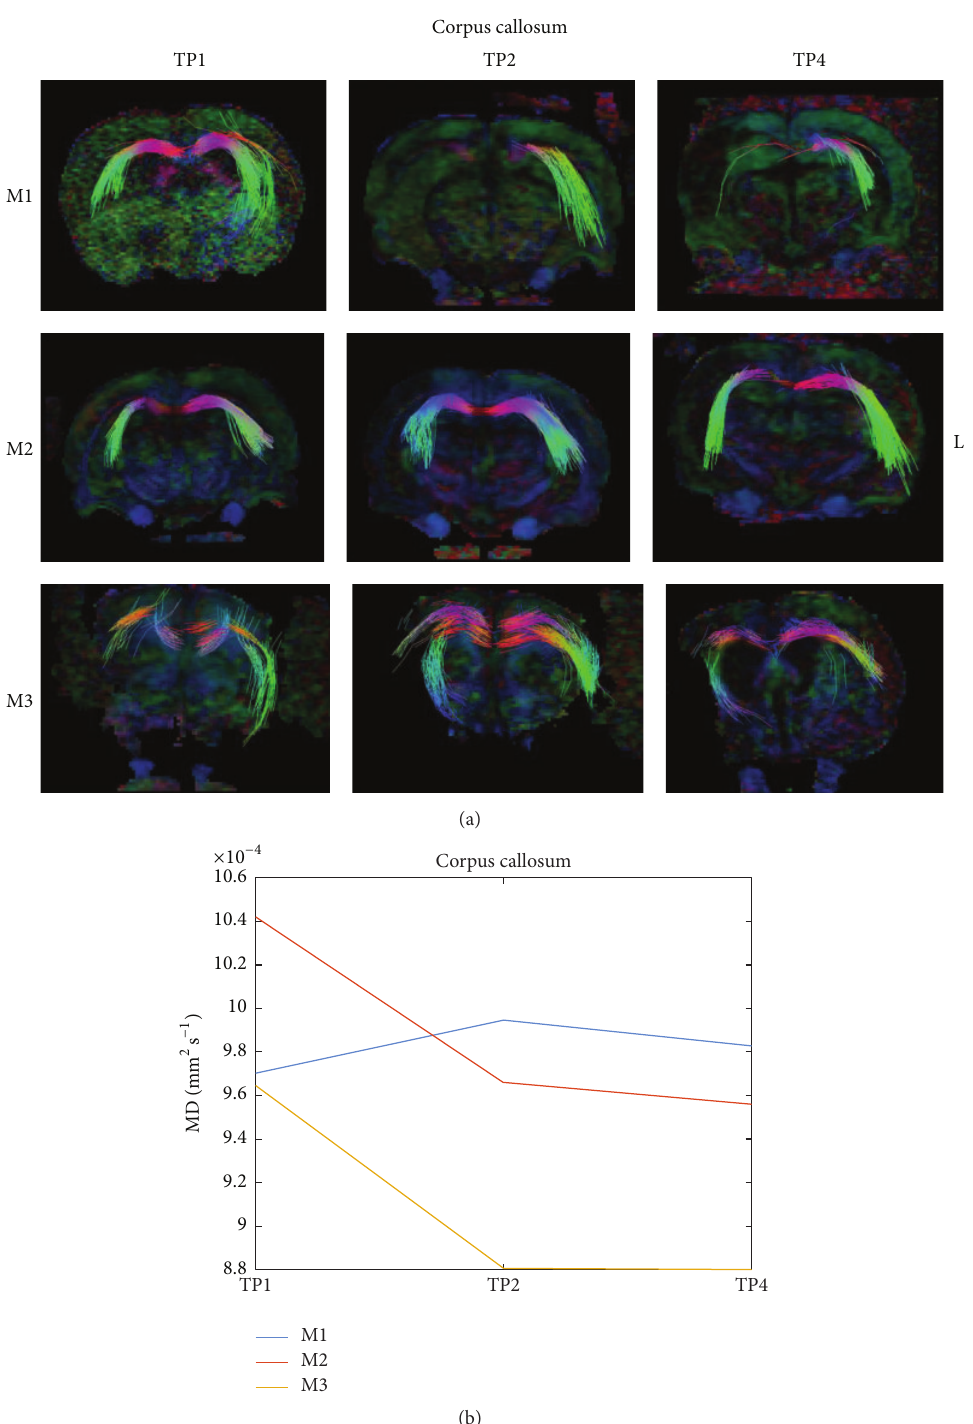
Figure 6: DTI of corpus callosum. A reconstruction of the corpus callosum white matter system (a) of the 3 examined rat groups (M1, M2, and M3 as described in Figure 4) at 3 time points (TP1, TP2, and TP4 as described in Figure 4). The median diffusivity of the fiber system was extracted and is shown in